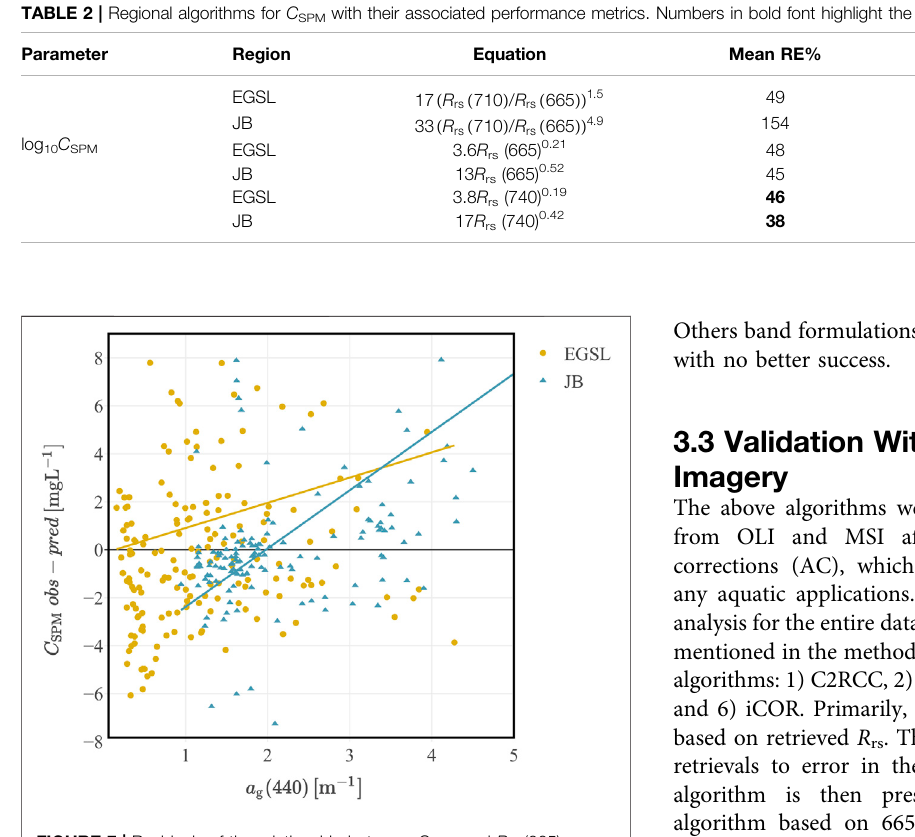
algorithm for C SPM used a single re fl ectance at 740 nm ( Figure 6 ), which is slightly better than 665 nm band used